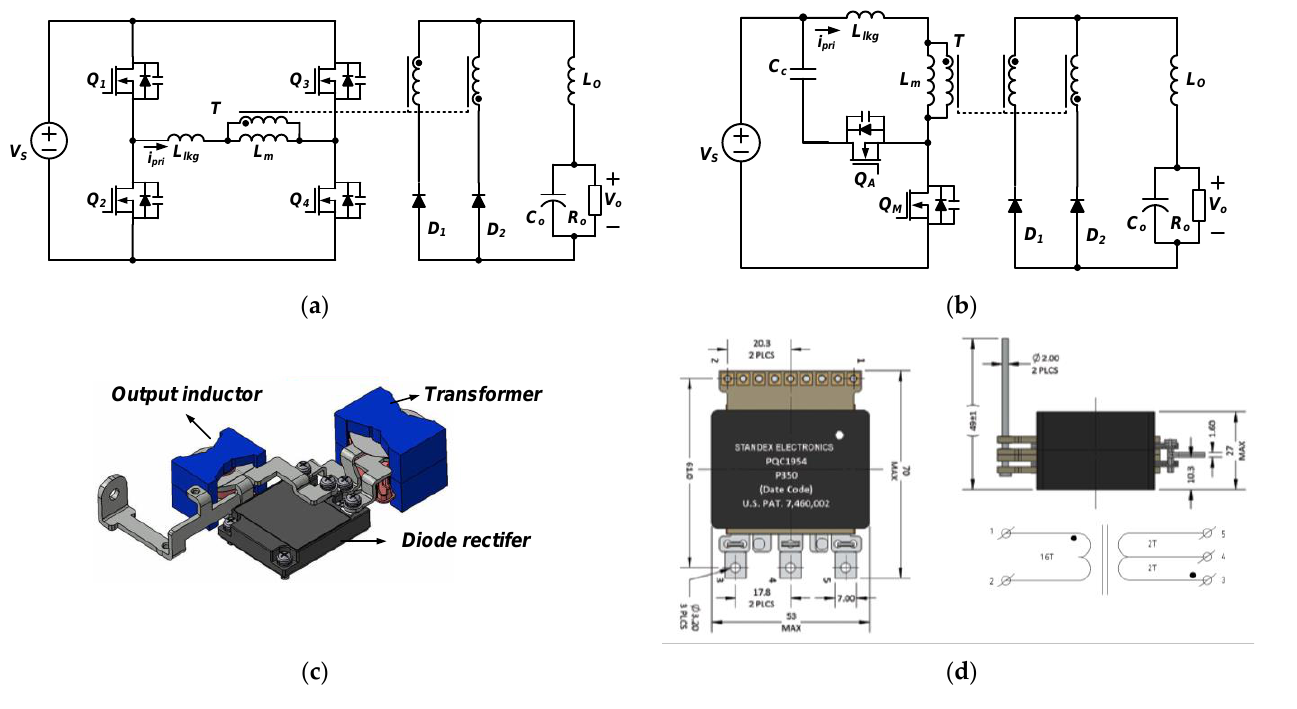
Figure 2. Conventional converters: ( a ) Phase-shifted full-bridge (PSFB) converter. ( b ) Active-clamp forward (ACF) converter. ( c ) Complex structure of transformer and secondary rectifier. ( d ) Conven- tional commercial planar transformer with about 2 kW output power.